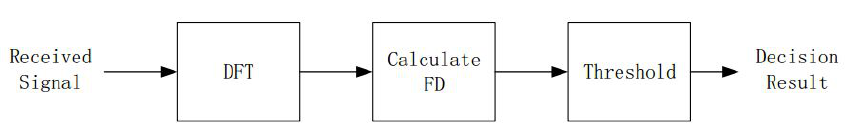
Figure 3. The block diagram of spectrum sensing system based on Sevcik fractal dimension (SFD) in the frequency domain. DFT: discrete Fourier